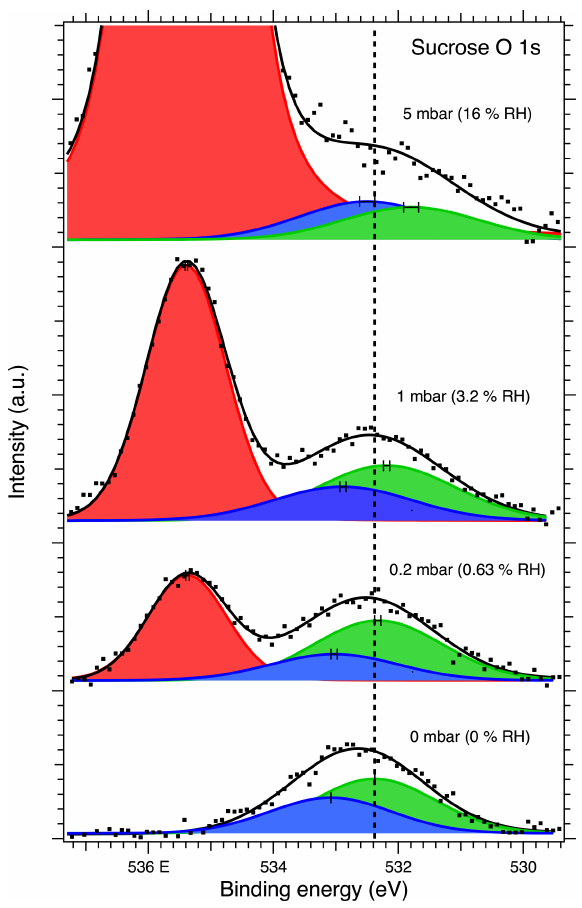
Figure 6. O 1s XPS spectra of sucrose aerosol particles. The dots show the recorded data, the solid lines the fit envelope curve, and the red, blue and green peaks the water vapor and sucrose O–C–O and C–O components, respectively. The dashed vertical line shows the binding energy of the C–O component at 0mbar pressure (0% RH) at the beginning of the experiments. Error bars show the estimated uncertainty in the peak position from Monte Carlo analysis. Photon energy was 1253.6eV from the Mg